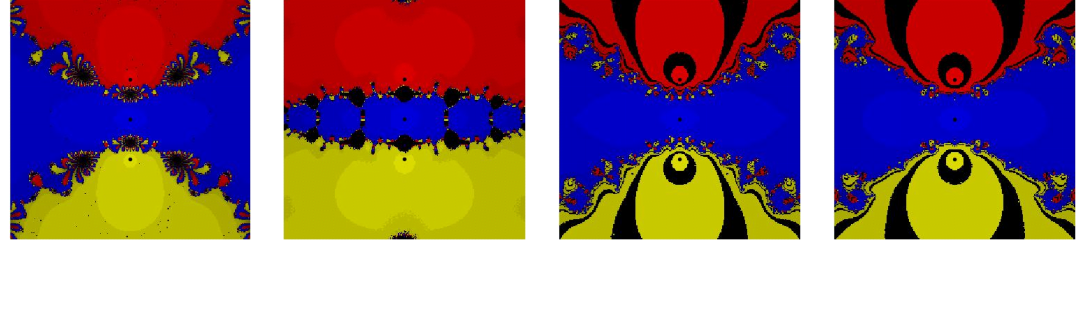
Fig. 2. Comparison of basin of attraction of methods (13), (18), (20) and (22) for test problem p 2 .z/ D z 3 C